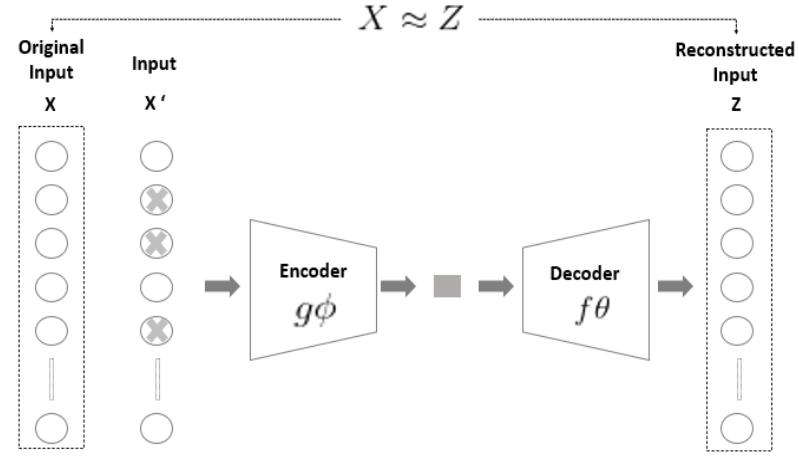
Figure 2. Structure of the denoising autoencoder.